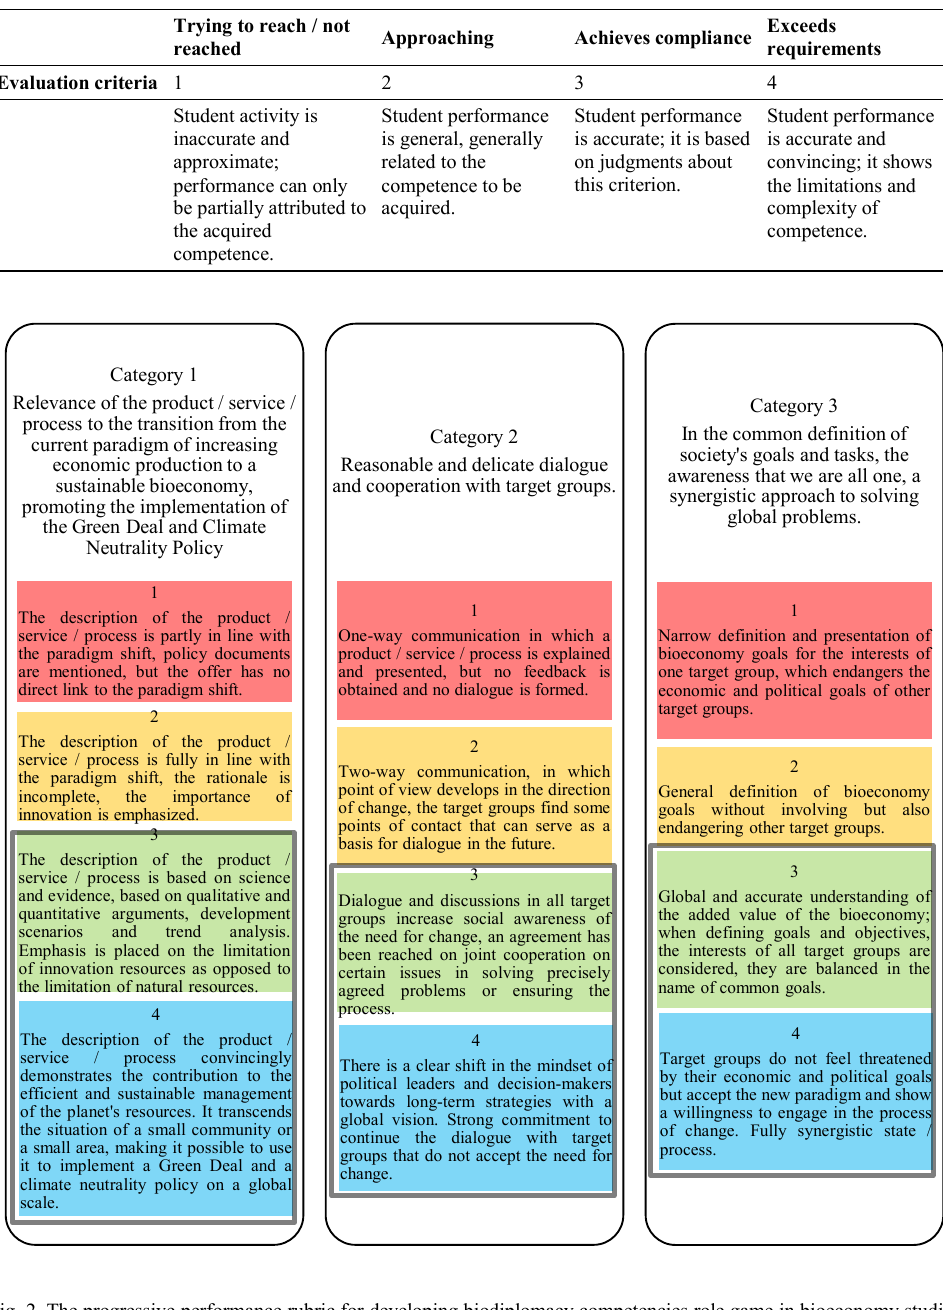
Fig. 2. The progressive performance rubric for developing biodiplomacy competencies role game in bioeconomy studies (1 – Trying to reach/not reached; 2 – Approaching; 3 – Achieves compliance; 4 – Exceeds requirements (explained in Table